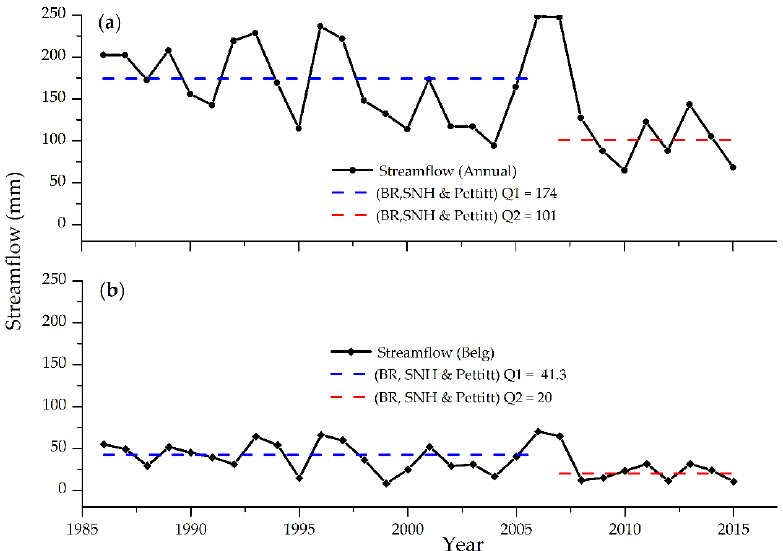
Figure 9. Changing point detection of streamflow in the Bilate watershed for the period 1986–2015: ( a ) the annual and ( b ) the Belg season.